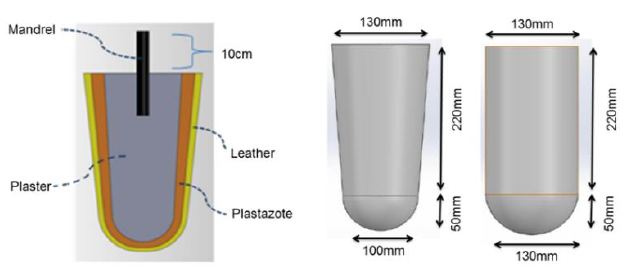
Figure 1: Positive mold. Left: cross-sectional view of positive mold (conical shape); Right: socket